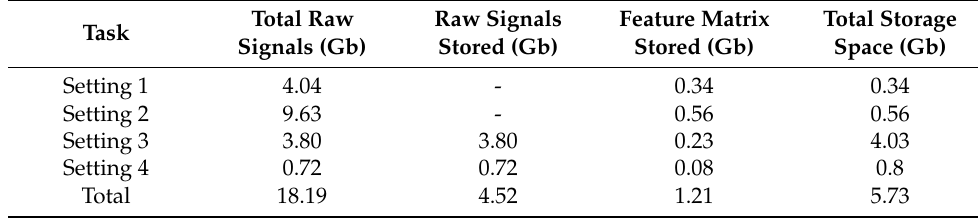
Table 6. Memory savings (Gb) .